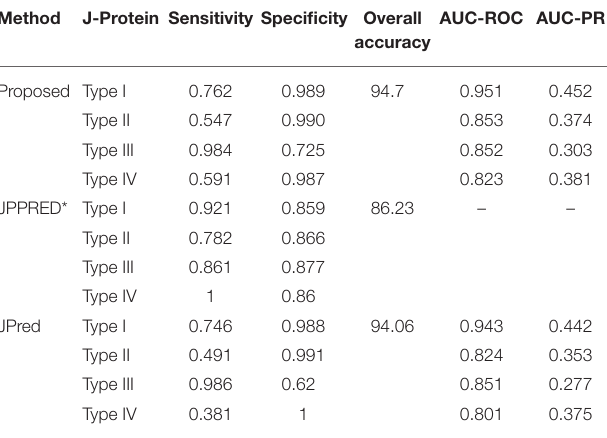
TABLE 7 | Performance metrics for the proposed approach, JPPRED and JPred with regard to classification of four types of DnaJ protein s . Method J-Protein Sensitivity Specificity Overall